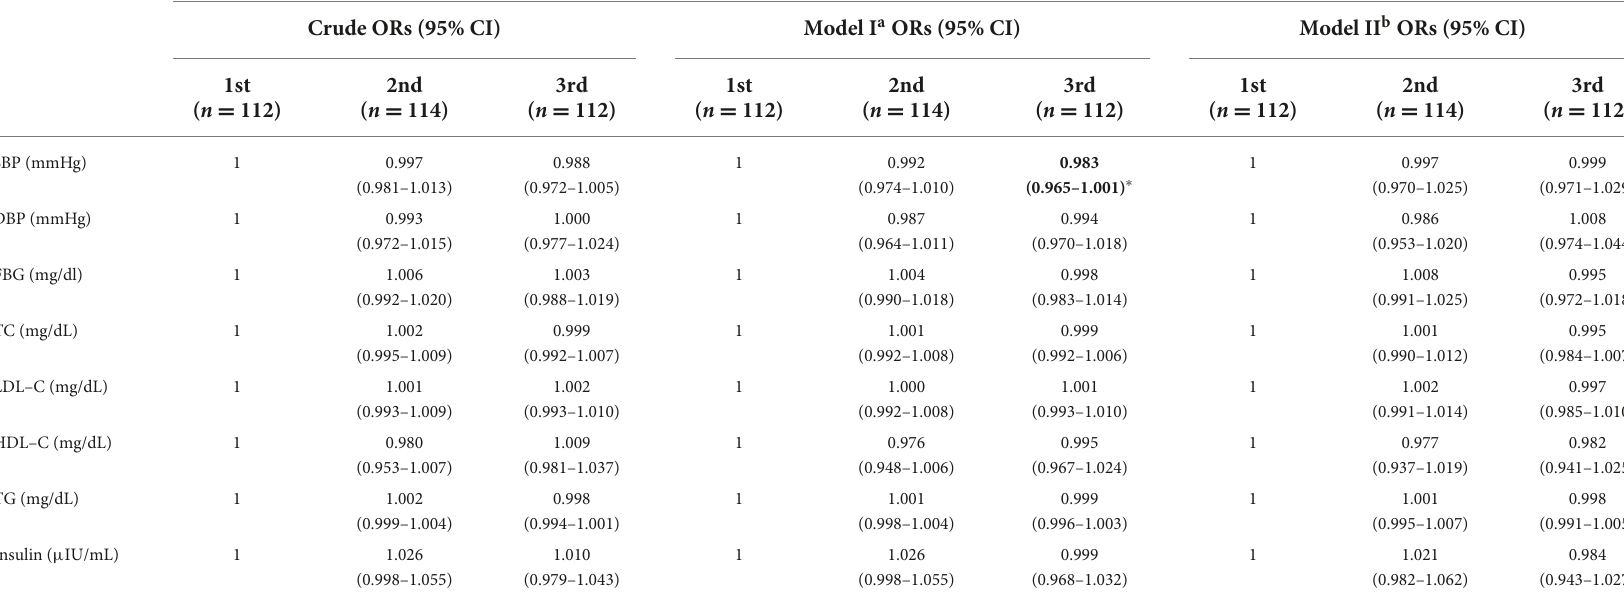
TABLE 5 Crude and multivariable adjusted ORs and 95% CIs for cardiometabolic risk factors across different tertiles of LLDS.